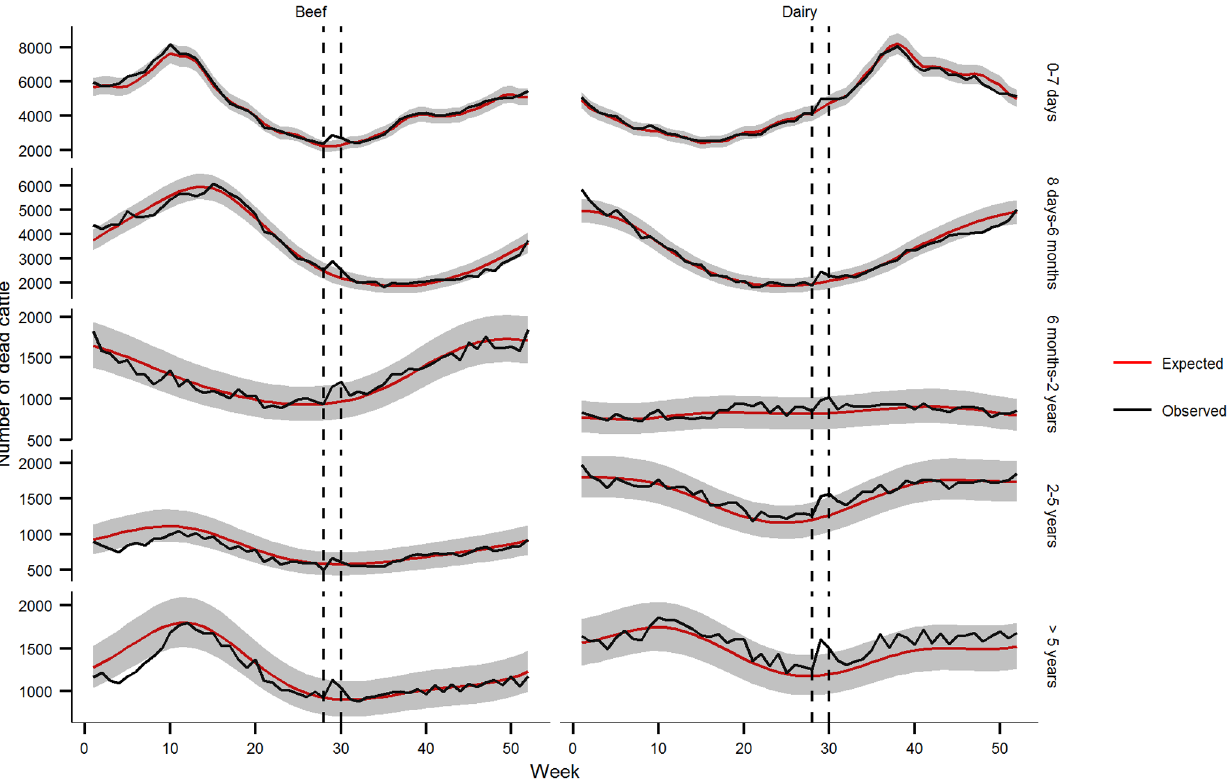
Figure 3. Comparison of observed and expected weekly cattle mortality in France in 2006 by age and production type. Dashed lines indicate the heat wave period. Expected mortality is represented by the red line (with the 99% confidence interval in gray), and observed mortality by the dark line. doi:10.1371/journal.pone.0093176.g003 and a lower impact on beef cattle (1.02) than dairy cows between 2 and 5 years (1.18) (Table2). No significant difference was found between production types for the other age classes.